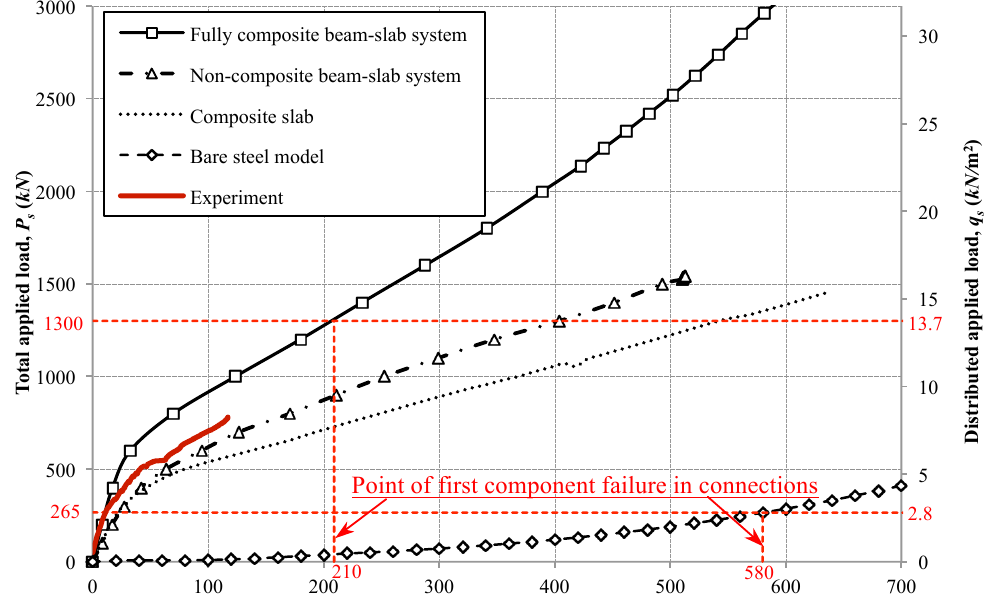
Figure 14. Nonlinear static response of examined floor systems under UDL